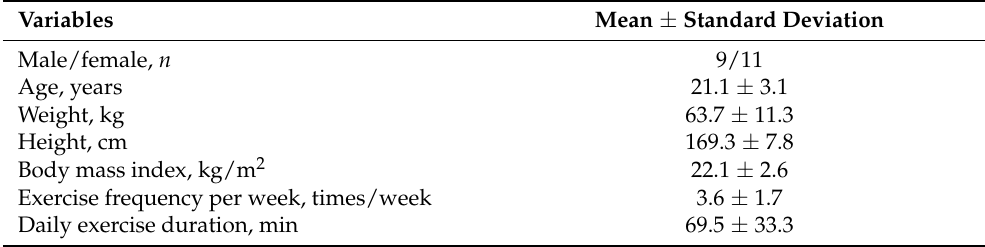
Table 1. Demographic characteristics of the